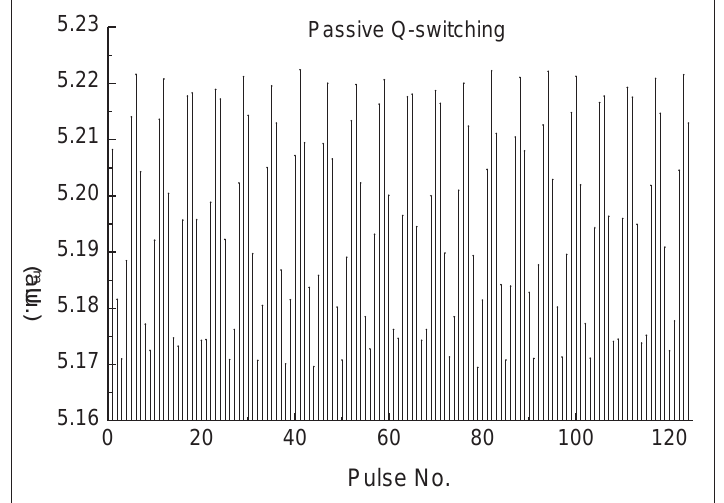
Figure3.TypicalpulsetrainobtainedusingmicrochiplaserwithpassiveQ-switching